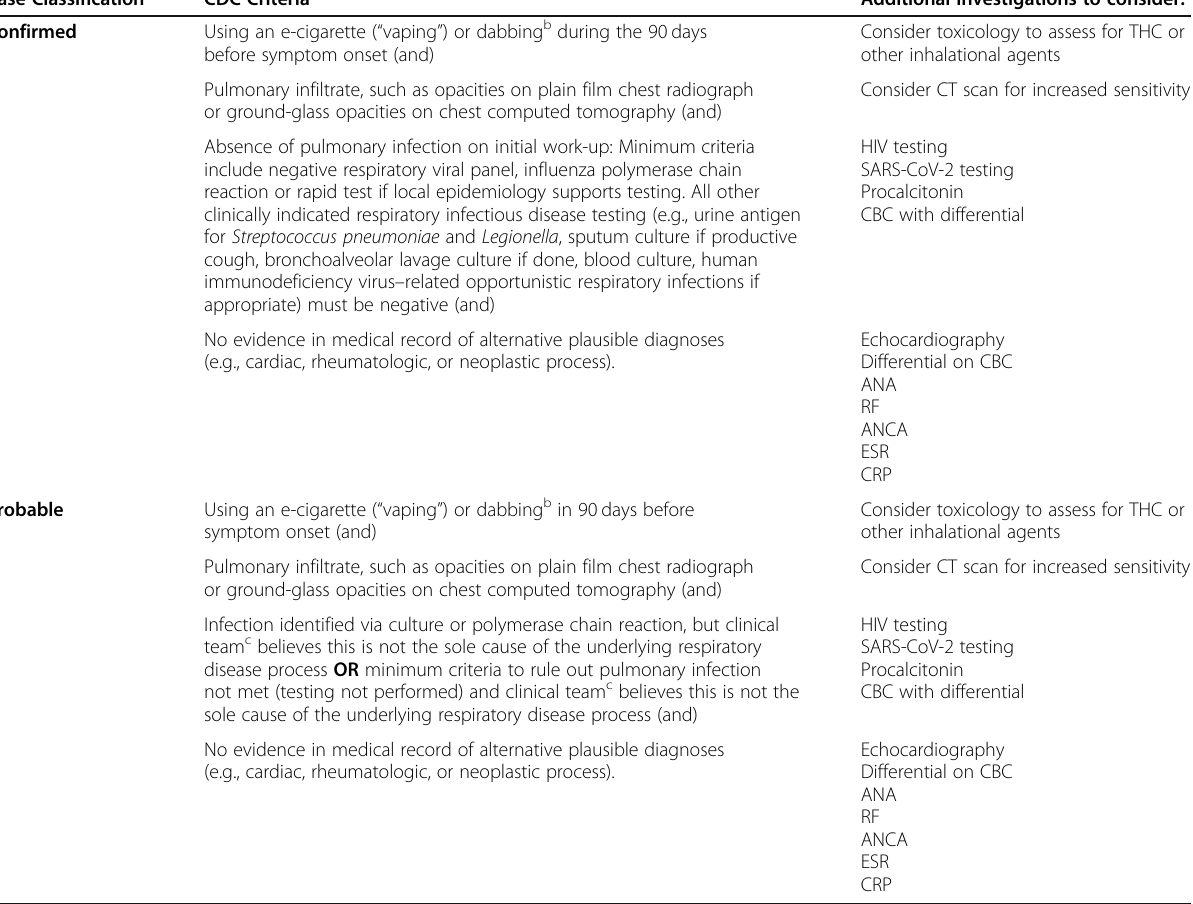
Table 1 CDC Surveillance Case Definitions a for Severe Pulmonary Disease Associated with Cigarette Use – August 30th 2019